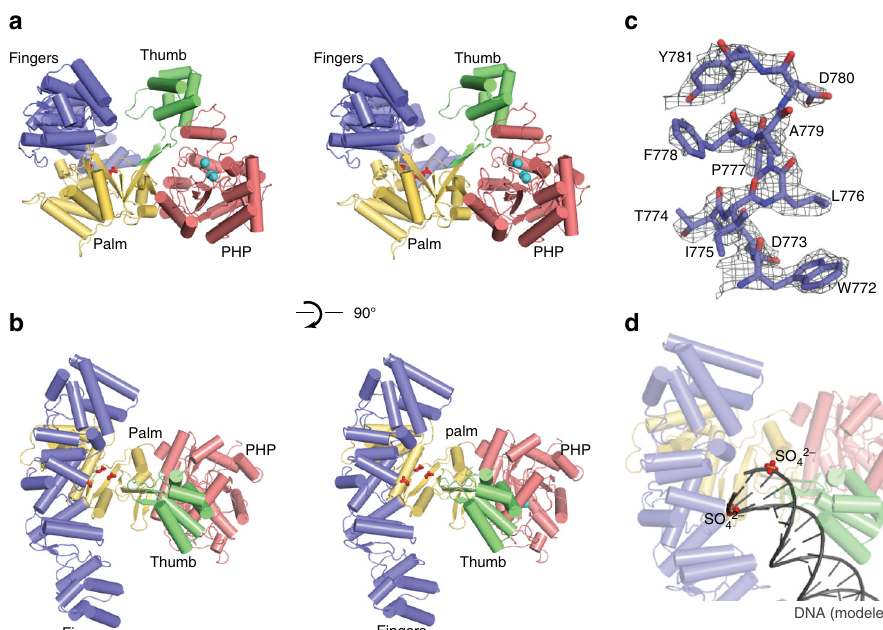
Fig. 1 Crystal structure of Mtb DnaE1. a Stereo image of the polymerase with domains indicated in different colors . The catalytic residues of the polymerase are shown in red sticks and the three metals in the PHP-exonuclease site are shown in blue spheres . b Stereo image of the polymerase, rotated by 90° from the view in ( a ). c Example of the electron density showing clearly de fi ned side chains. Electron density shown at 2.1 σ in gray . A stereo image is shown in Supplementary Fig. 1a. d Modeling of dsDNA into the polymerase active site reveals an almost perfect overlap between the DNA backbone and two SO 4 2 − ions that are bound in the polymerase active site. See also Supplementary Fig. 1b for a comparison to other